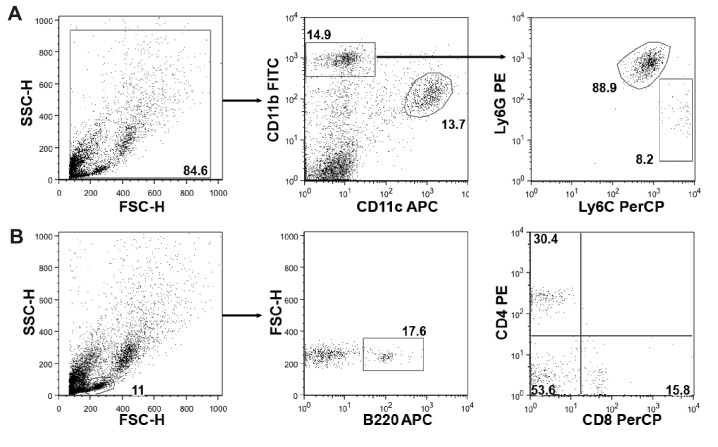
Gating strategy for flow cytometric analysis.(A) Cells were initially gated on Forward (FSC) and Side Scatter (SSC) and divided into CD11b+ and CD11c+ (dendritic cells and alveolar macrophages) cells. CD11b+ cells were further subdivided into Ly6G+ neutrophils and Ly6C+ inflammatory monocytes. (B) Lymphocytes were gated on FSC and SSC and subdivided into B220+ B cells, CD4+ and CD8+ T cells. Values shown indicate the % of gated or positive cells. FITC: Fluorescein isothiocyanate, APC: allophycocyanin, PerCP: Peridinin Chlorophyll Protein Complex.